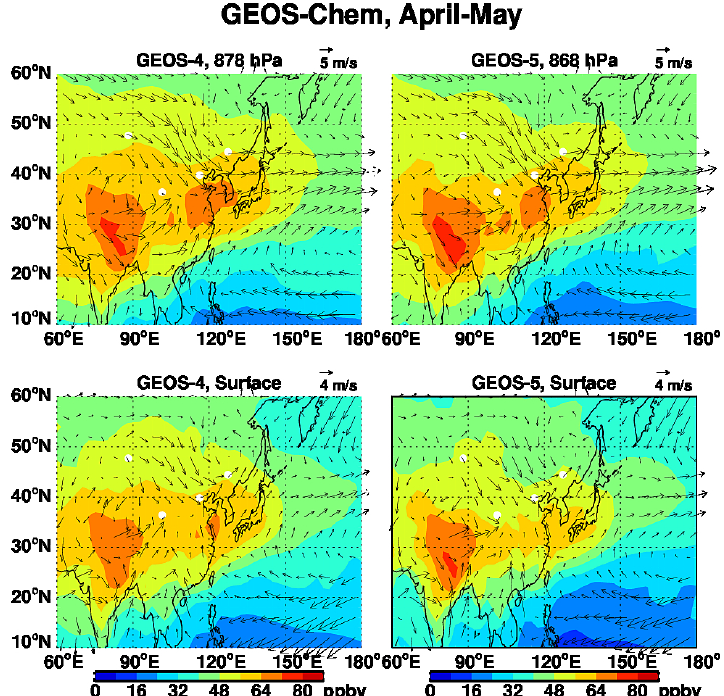
Figure 3. GEOS-4 (left panels) and GEOS-5 (right panels) horizontal wind vectors near the surface (lower panels) and ∼ 870hPa (upper panels) in eastern Asia during April–May 2005. Also shown as a color image are the O 3 concentrations (ppbv) simulated by GEOS-Chem driven with GEOS-4 and GEOS-5 meteorological data sets. Values are averages over April–May. White dots denote the locations of four ozonesonde stations (see Fig. 1).